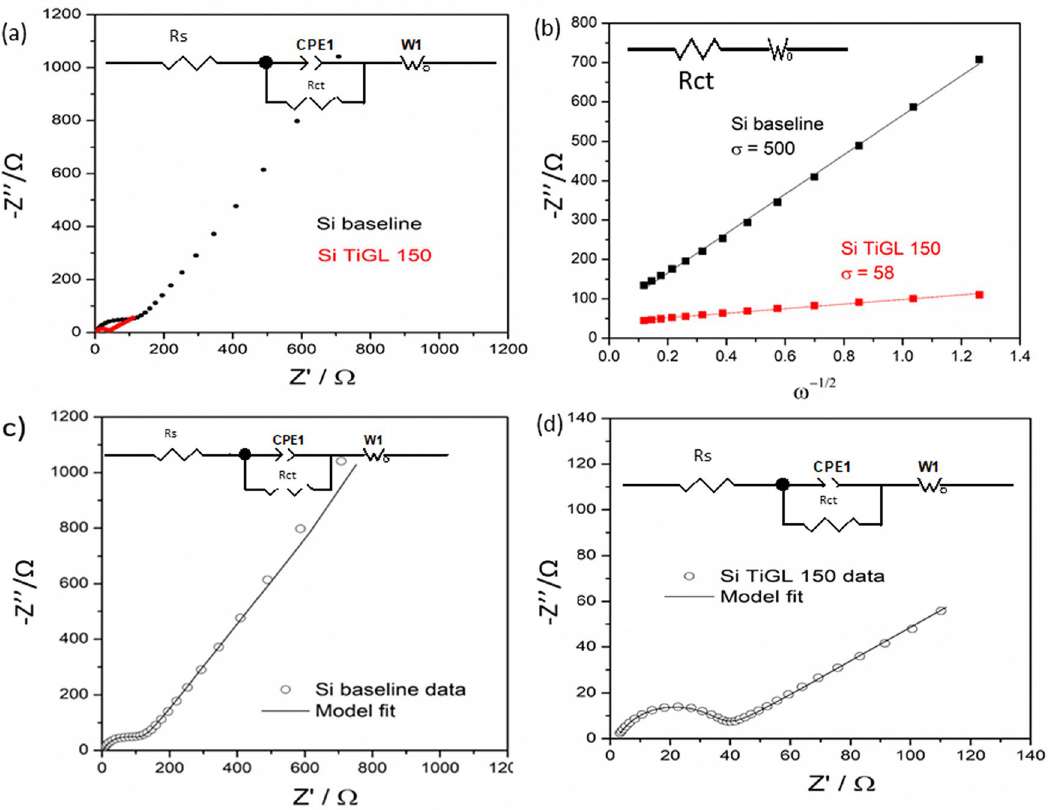
Figure 5. Impedance data presented in the form ( a ) Nyquist plots, ( b ) Z ′ vs ω −0.5 plots and fitting results using Randles circuit inset, and Si baseline and Si TiGL 150 data fitting using the equivalent circuit inset in ( c ) and ( d ), after activation